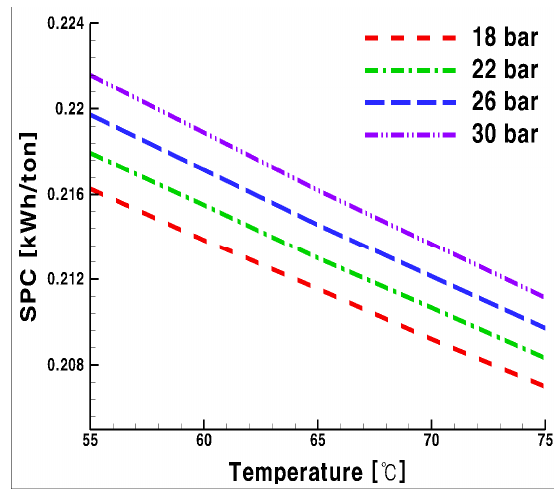
Figure 4. Changes in the SPC based on temperature with respect to the operating pressure when using CO 2 .